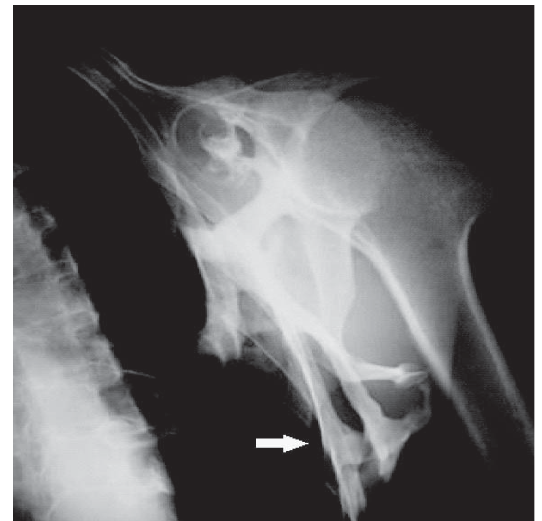
Fig 6. X-ray right shoulder joint oblique view showing diffuse soft tissue ossification overlying the right chest wall and axilla (white arrow)